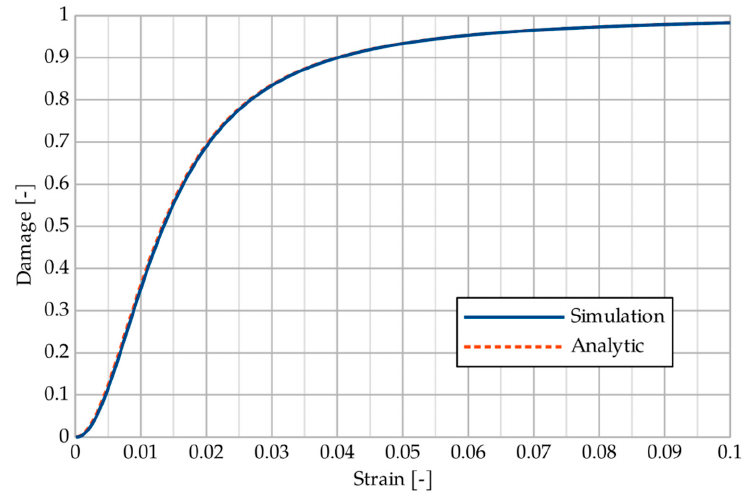
Figure 6. Damage vs. axial strain relationship for the one element example.